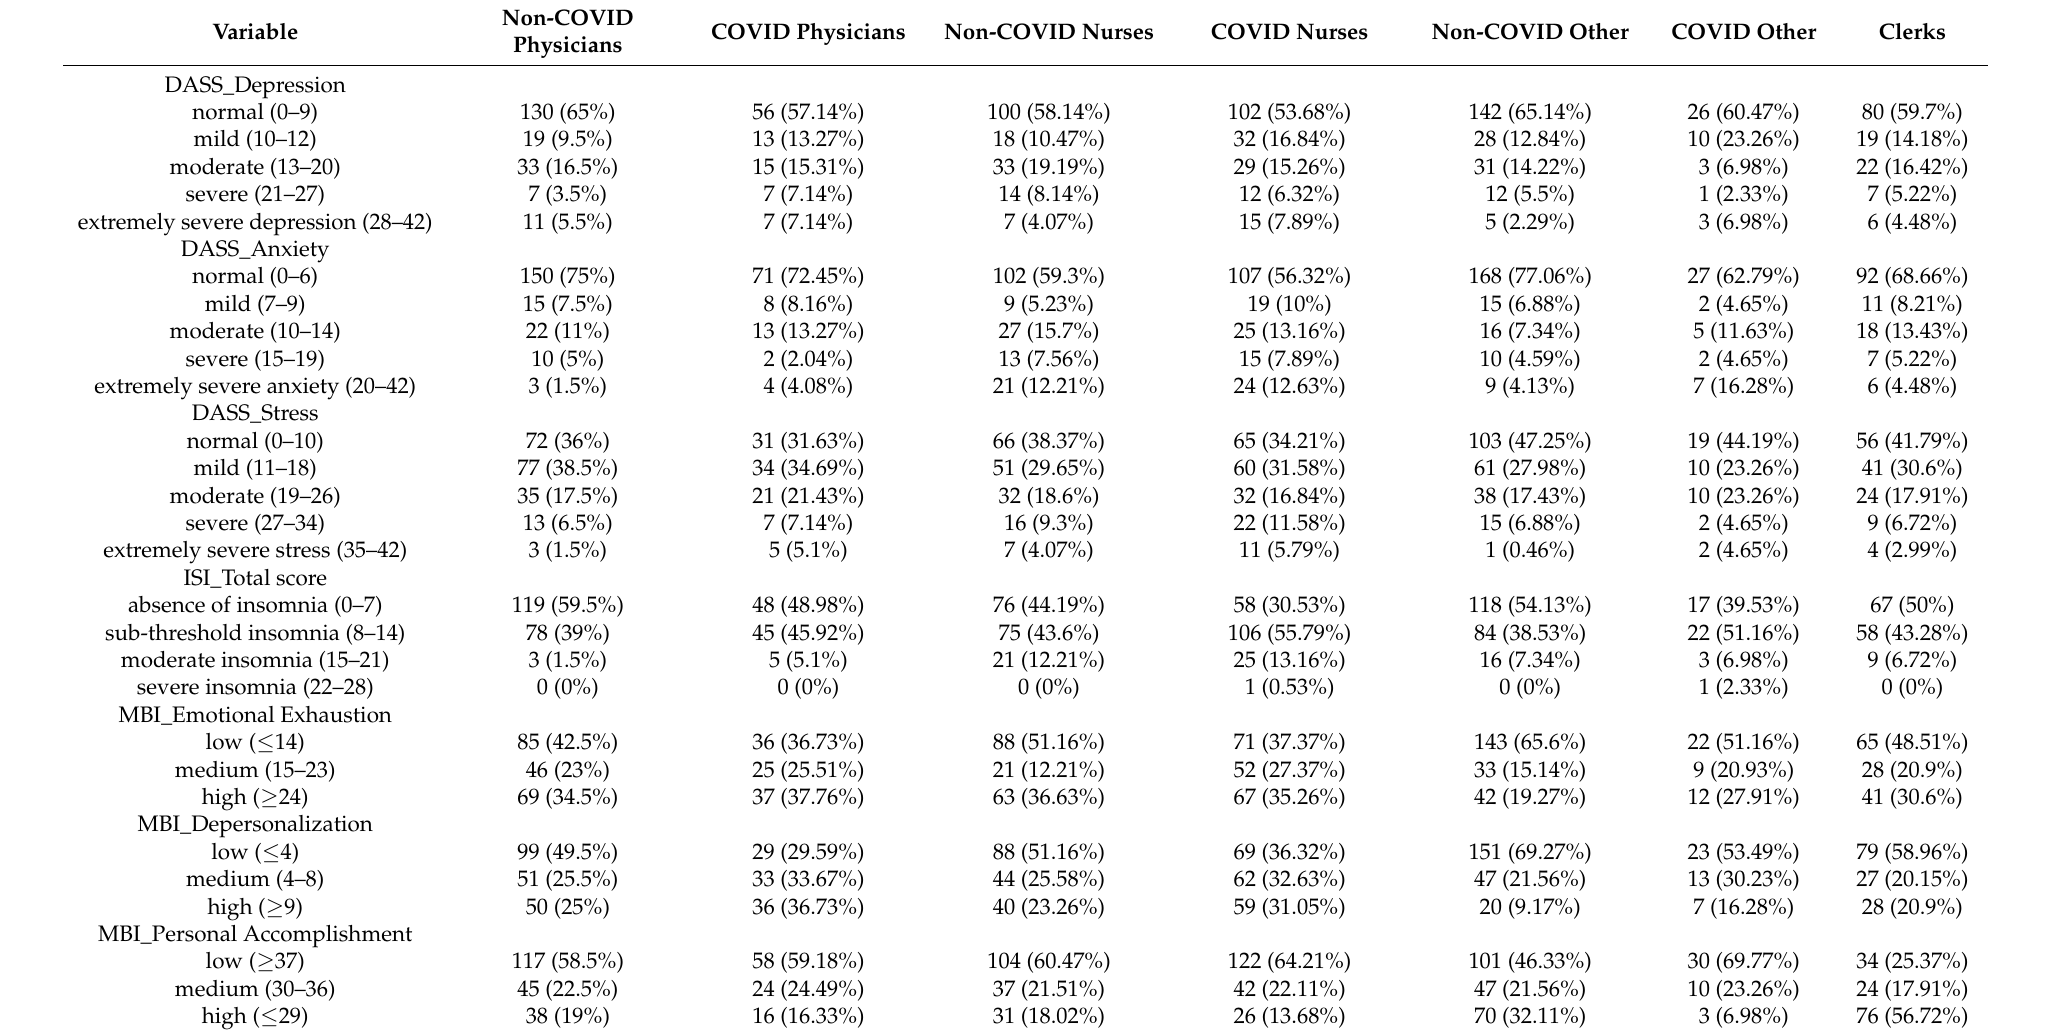
Table 2. Distress levels distribution according to the cut-off values reported in the